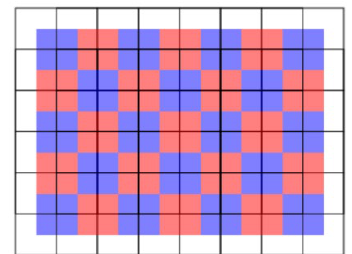
Figure 3 . Final prediction building scheme. Red and blue parts of pictures (middles of tiles) are connected side by side to reduce effect of false classification on edges.